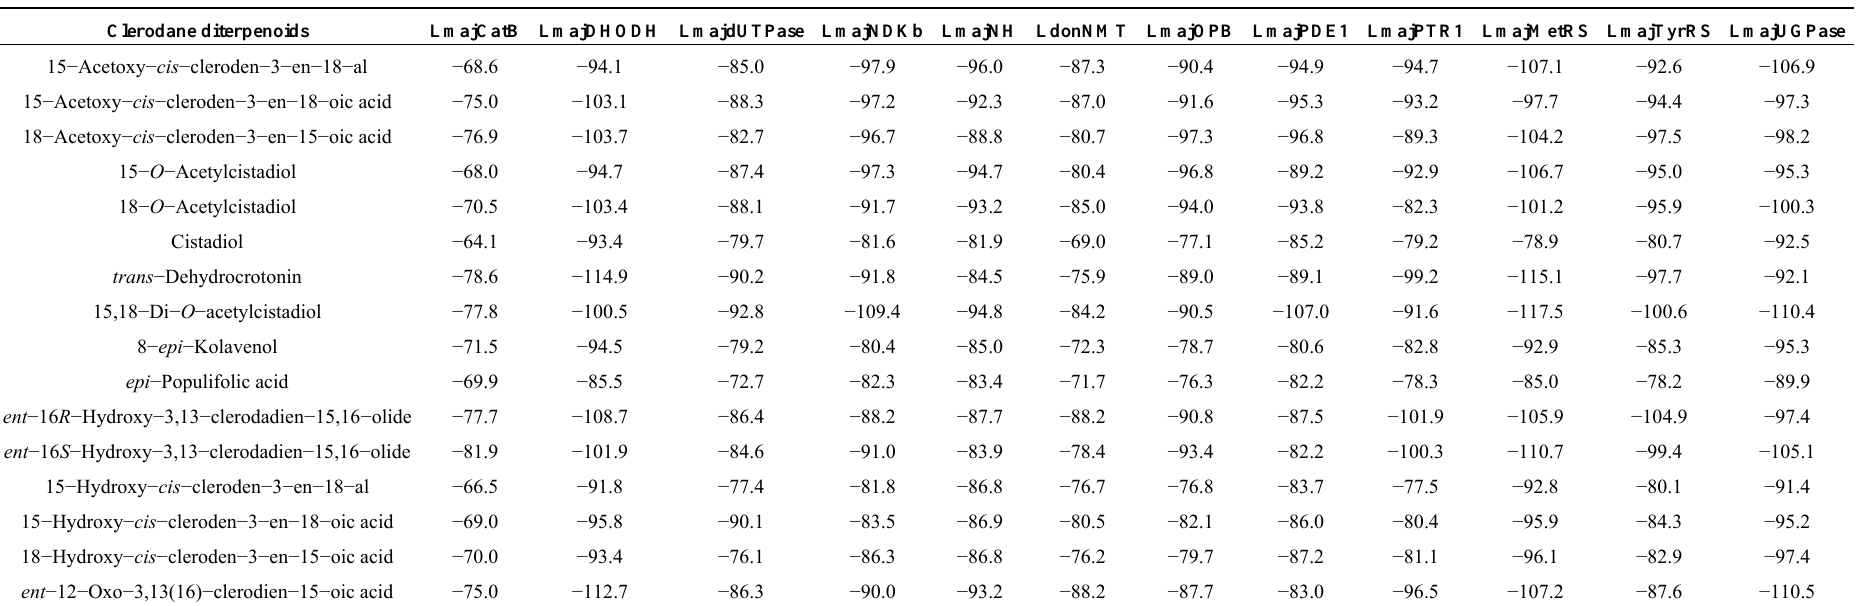
Table 19. MolDock docking energies (kJ/mol) of clerodane diterpenoids with Leishmania major protein